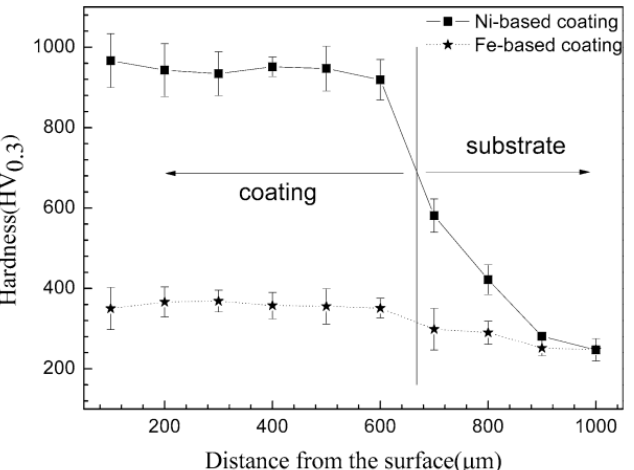
Figure 23. Microhardness of the Ni-based and Fe-based coatings on 40Cr steel (the laser power is 2000 w, and the scanning speed is 90 mm/min) [118].